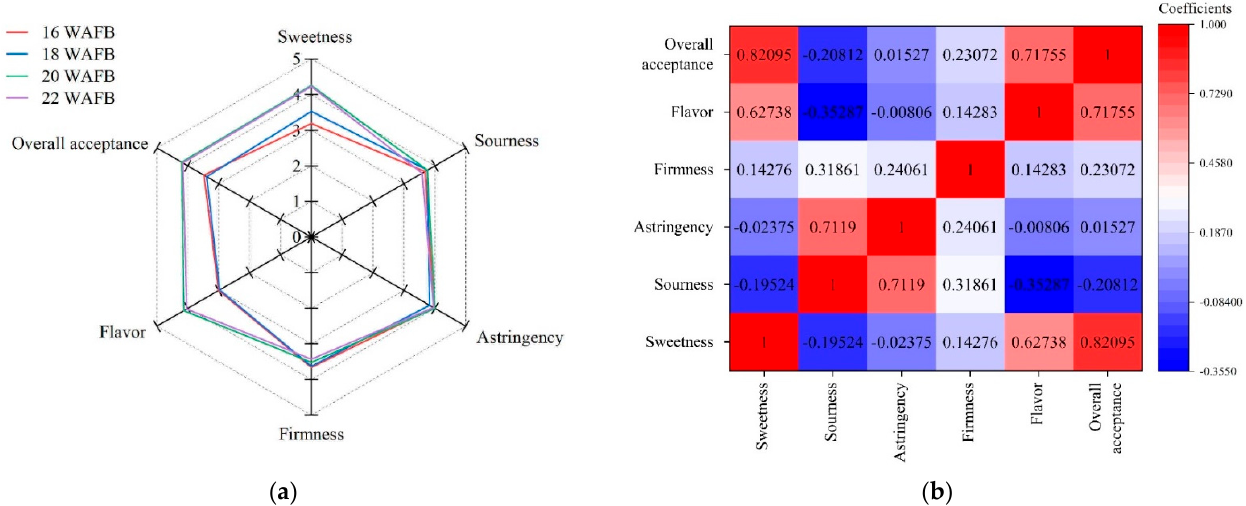
Figure 4. Schematic representations of ( a ) a radar plot of hedonic sensory properties of Shine Muscat grapes harvested at 16, 18, 20, and 22 weeks after full bloom (WAFB), and ( b ) heatmap of Pearson’s correlation coefficient matrix between sensory